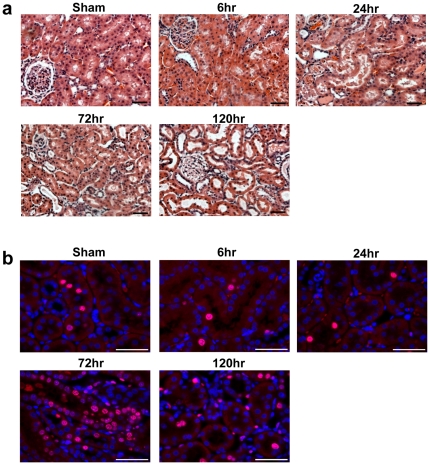
Histological and immunohistochemical examination of kidney tissue injury and repair following I/R injury.Representative formalin fixed paraffin embedded kidney tissue sections of sham male Wistar rats and those undergone 20 min bilateral ischemia reperfusion over time stained by (A) Hematoxylin and Eosin (40× magnification) and (B) Ki-67 (60× magnification). n = 5/group. Bar represents 50 µm.